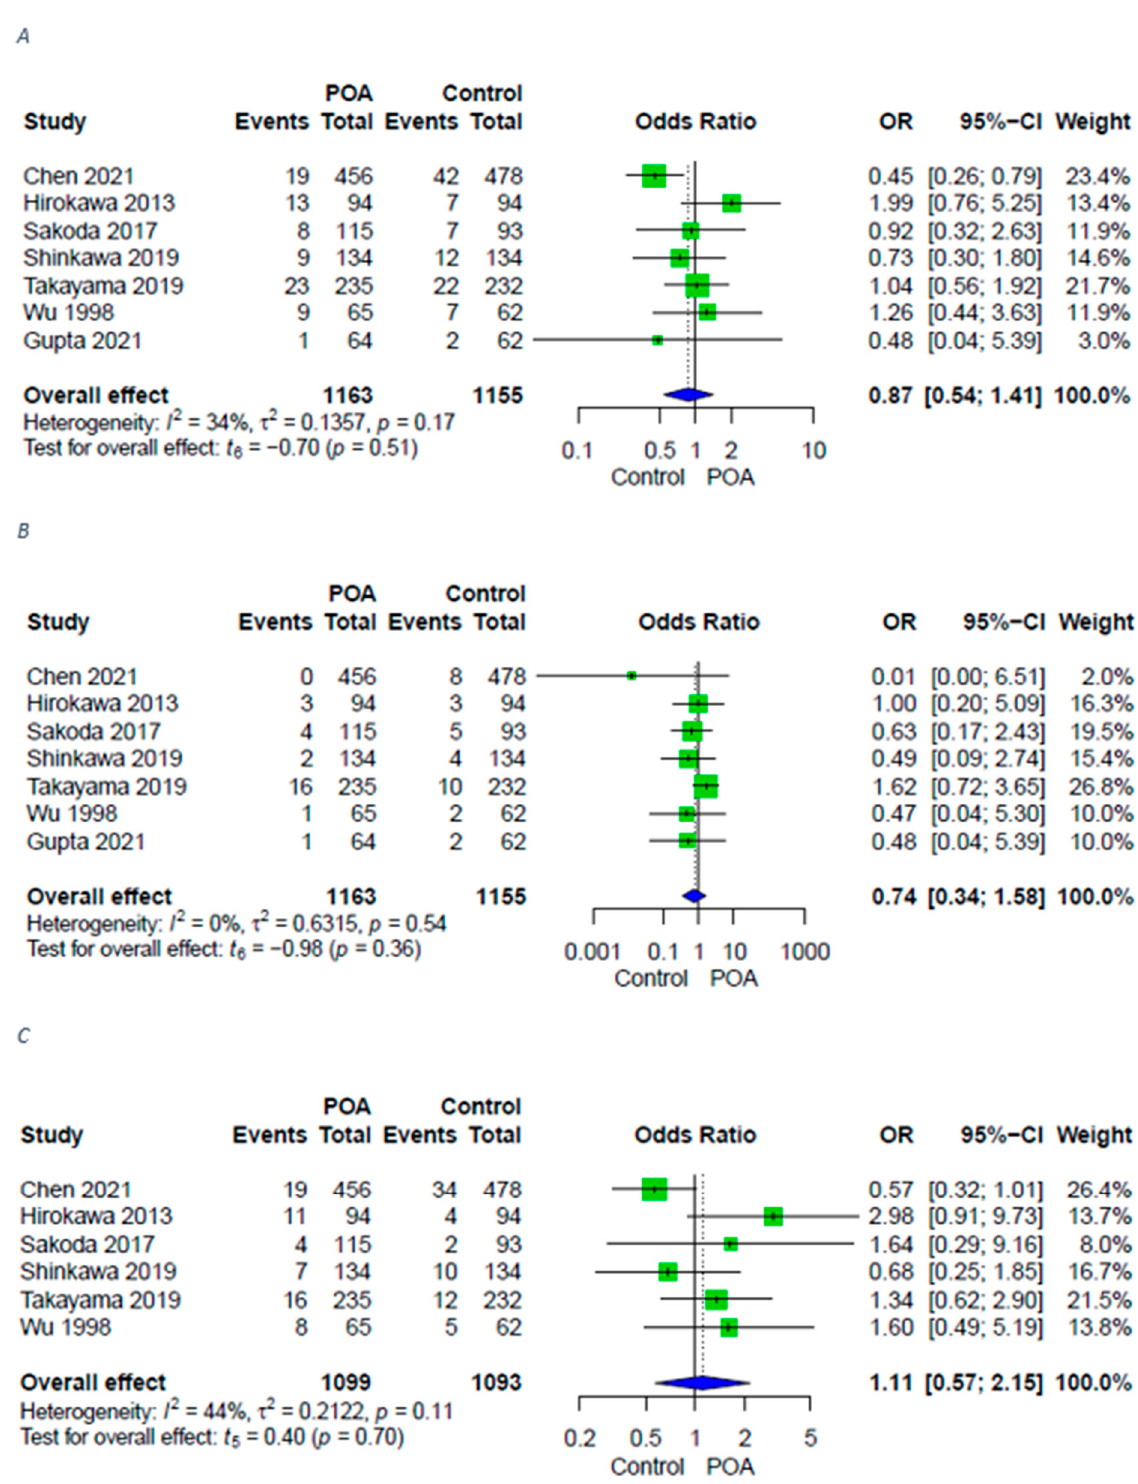
Figure 2. Forest plots for surgical site infections in patients with POA versus control. ( A ) Forest plot for surgical site infections in patients with POA versus control; ( B ) Forest plot for superficial surgical site infections in patients with POA versus control; ( C ) Forest plot for deep surgical site infections in patients with POA versus control. A random-effects model was utilized for all outcomes due to heterogenic methodological and clinical framework of included studies. Statistical heterogeneity was evaluated using the I 2 statistics. An I 2 value below 25% indicated low heterogeneity, while over 75% was considered high.